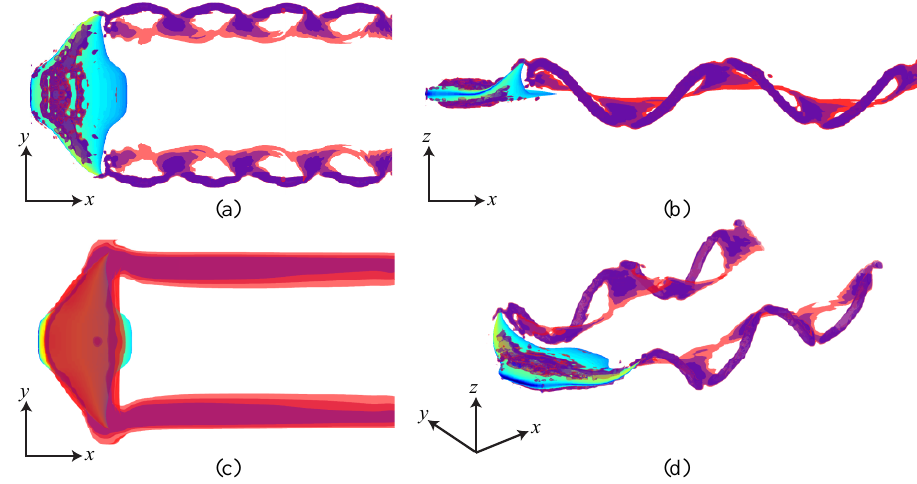
Figure 13. ( a ) Isosurfaces of the 𝜆 2 criteria are shown to mark the vortex system (top view). Going from pink to purple the isovalues are 𝜆 2 = −0.02,−0.03, and −0.05, respectively for the vortices in ( a , b , d ); ( b ) Side view of vortex structures; ( c ) Isosurfaces of the time-averaged x -component of velocity. Going from pink to purple the isovalues are 1%, 1.5% and 2% of the steady-state of the cycle-averaged velocity; ( d ) Perspective view of vortex structures.